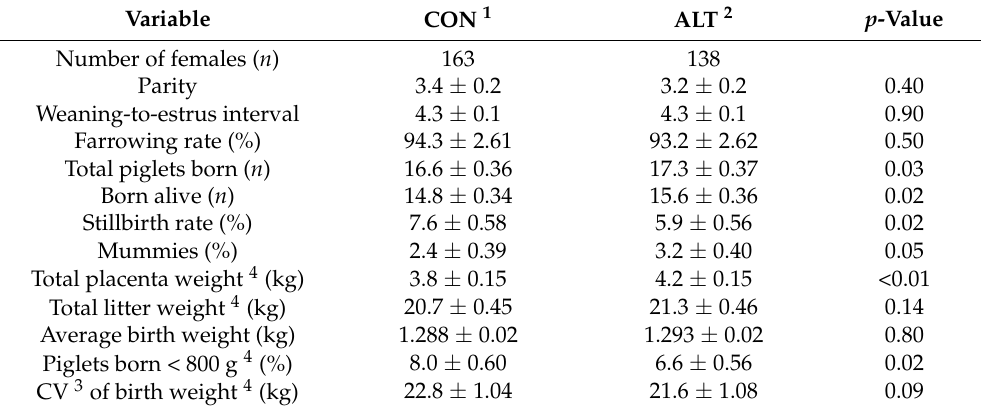
Table 1. Effects of altrenogest (Regumate ® , Merck—Animal Health) supplementation from day 6 to 12 of pregnancy on sows’ and litter performance at